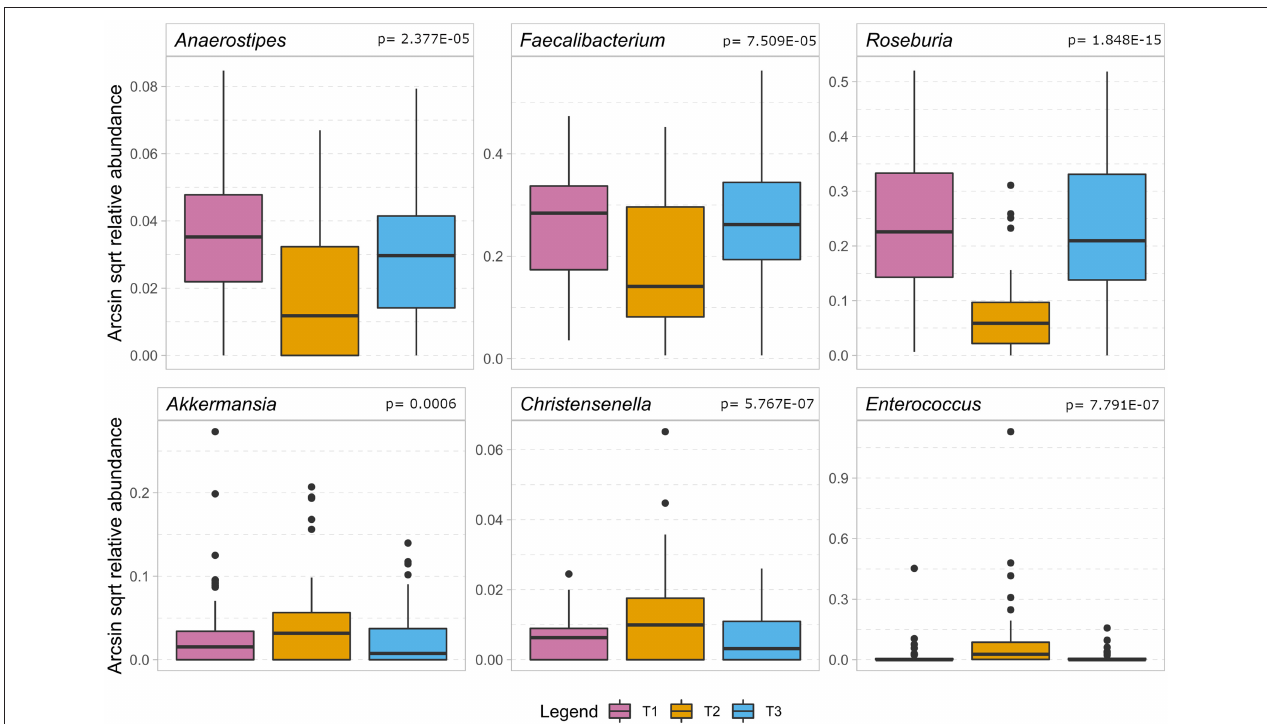
FIGURE 4 | The boxplot shows the results of the association analysis of the gut microbiota in ICU patients over time. In the top row a selection of beneficial butyrate-producing gut bacteria (for details, cf. Supplementary Material 6 ) show a significant decrease during the stay at the intensive care unit. In the bottom row we show bacteria that significantly increase during hospitalization of which Enterococcus is considered a pathobiont while the other two are regarded as beneficial to gut health. In the analysis, only taxa remaining after application of FDR < 0.05 are considered significant and the p -value of the quadratic component of the model is depicted in the